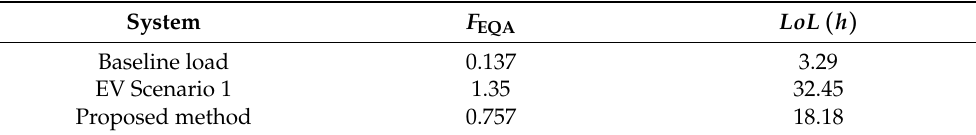
Figure 8. Transformer life indices in scenario 1, ( a ) hottest-spot temperature, θ H ; ( b ) accelerated aging factor, F AA . Table 2. F EQA and LoL in scenario